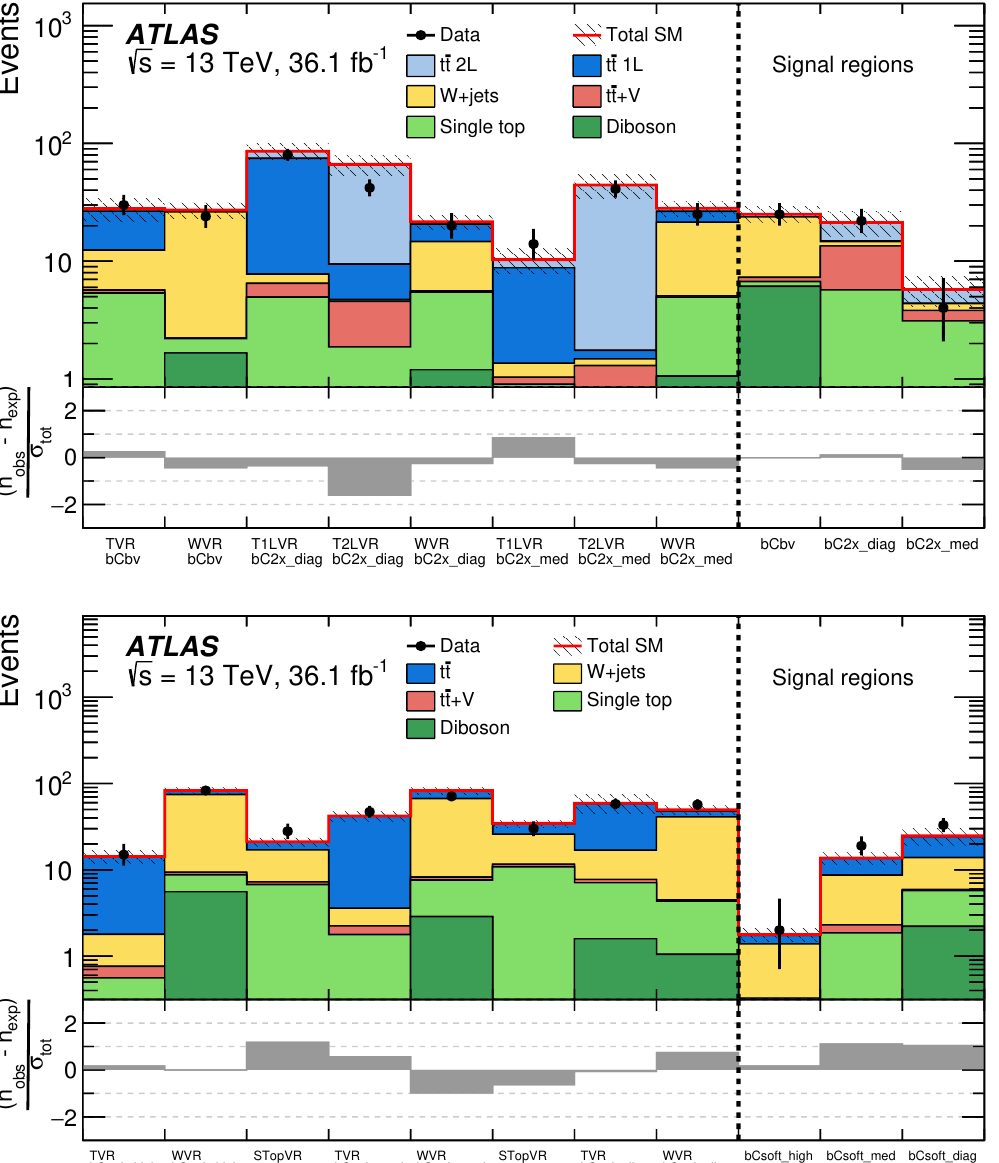
Figure 16 . Comparison of the observed data ( n obs ) with the predicted SM background ( n exp ) in (top) the bCbv , bC2x diag , and bC2x med signal regions, (bottom) the bCsoft high , bCsoft med , and bCsoft diag signal regions, together with associated VRs. The background predictions are ob- tained using the background-only (cid:12)t con(cid:12)guration, and the hatched area around the SM prediction includes all uncertainties. The bottom panels show the di(cid:11)erence between data and the predicted SM background divided by the total uncertainty ( (cid:27) tot